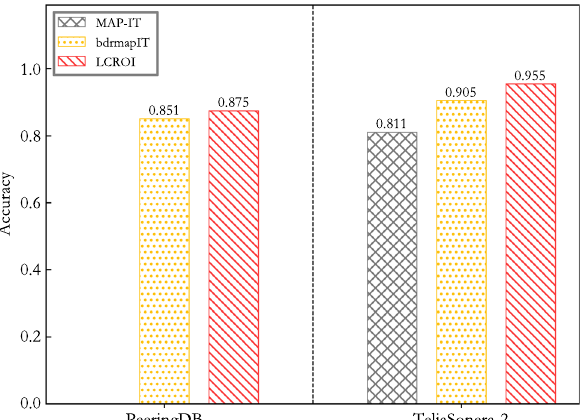
Figure 8. Comparison between LCROI and other methods using MIDAR 40 , iffinder 41 , and kapar 42 for alias